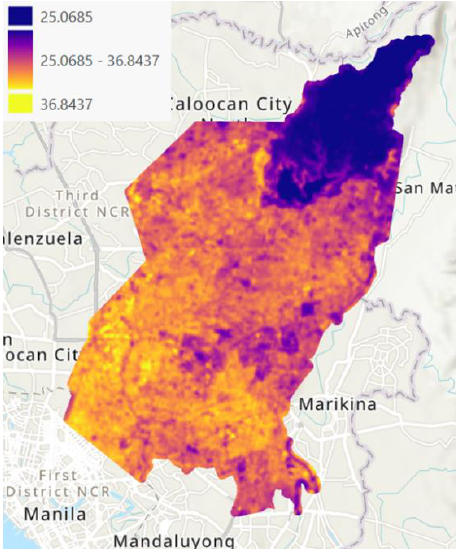
Figure 4. Spatial distribution of land surface temperature (LST) in Quezon